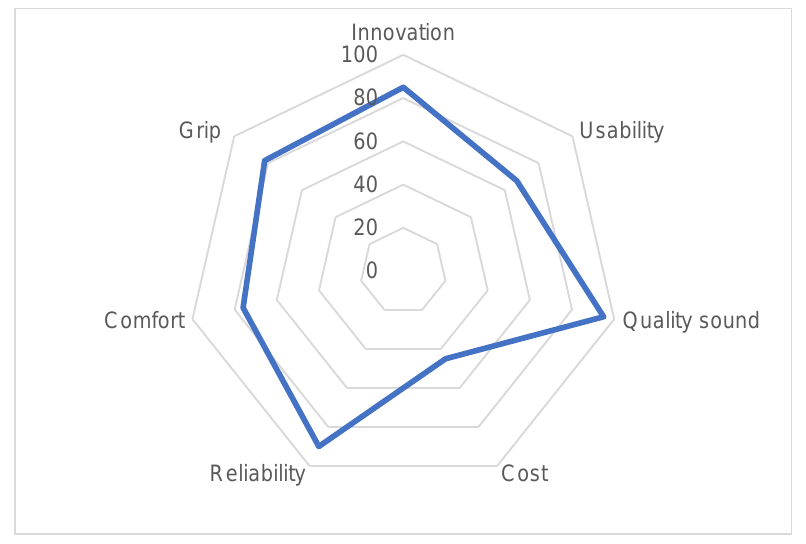
Figure 9. Main features of Flow concept according to users’ assessment.